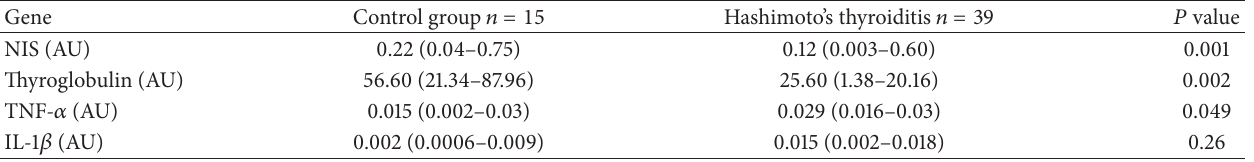
Table 2: The expression of the genes studied in patients with Hashimoto’s thyroiditis and healthy controls.